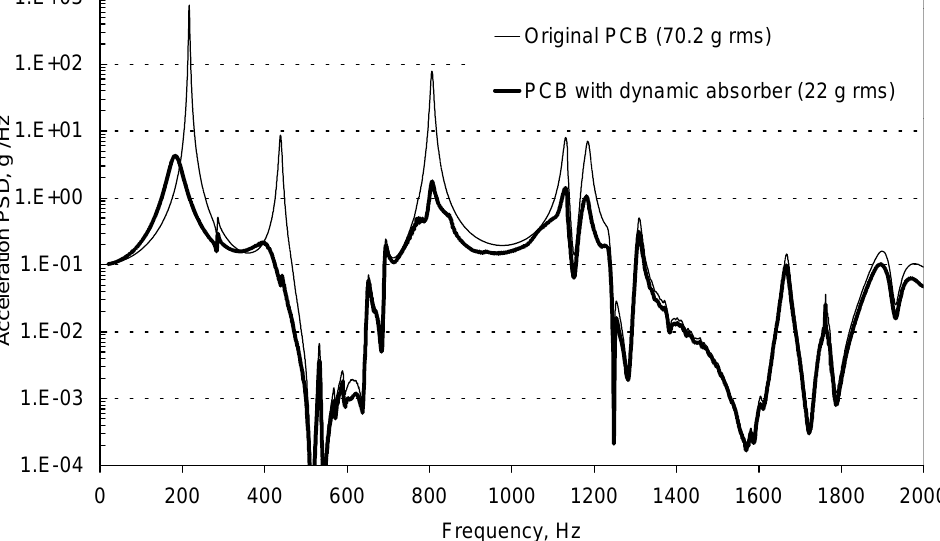
Fig. 5. Performance of the optimal dynamic absorber: PSD of absolute acceleration of original and modified PCB in the control